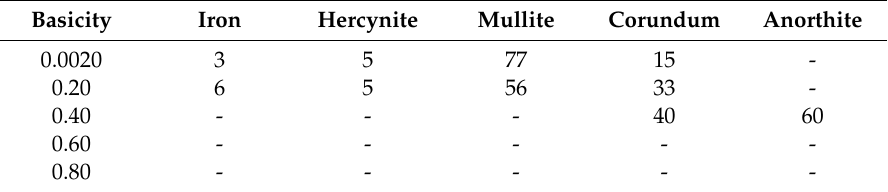
Figure 14. Microstructures of the slags obtained from smelting separation at different basicity levels. Table 8. The EDS analysis of Figure 14 (wt. %). Point